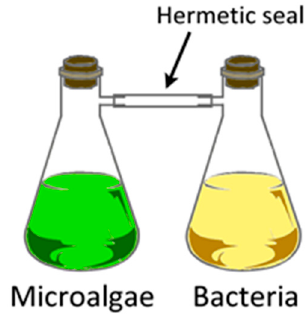
Figure 13. Schematic of an experimental set-up for intra- and inter-species continuous communication. Figure adapted from [161] with permission.